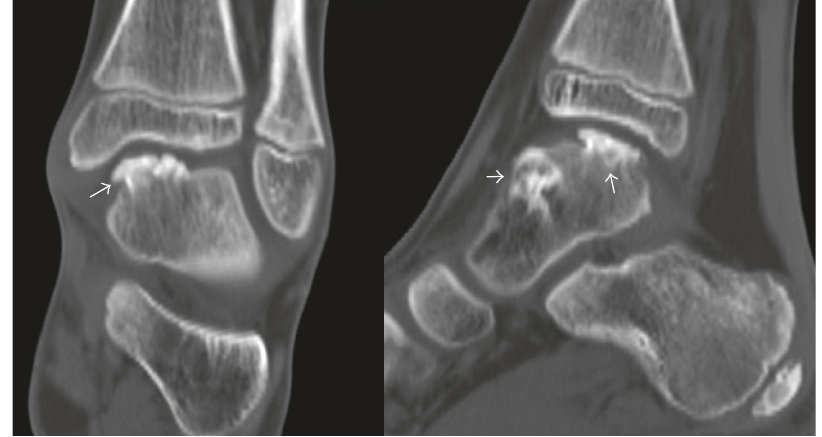
Figure 2: The CT scan shows the bony-like protuberances arising at the anteromedial and posteromedial aspect of the talus (arrows) and the relationships with the other bone structures of the ankle.